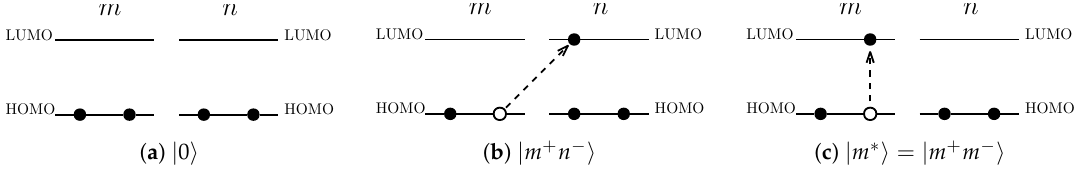
Figure 2. The ground and excited states in the PPC. Electrons and holes are represented by filled circles and open circles respectively. The arrows show how the excited states are created from the ground state by the transfer of an electron from HOMO to LUMO. ( a ) All of the HOMOs are occupied in the ground state, | 0 (cid:105) . ( b ) The excited state, | m + n − (cid:105) , is created by transferring an electron from the HOMO at pigment m to the LUMO at pigment n . ( c ) The FE state is a special case of | m + n − (cid:105) in which electron transfer is made within the same pigment ( n = m